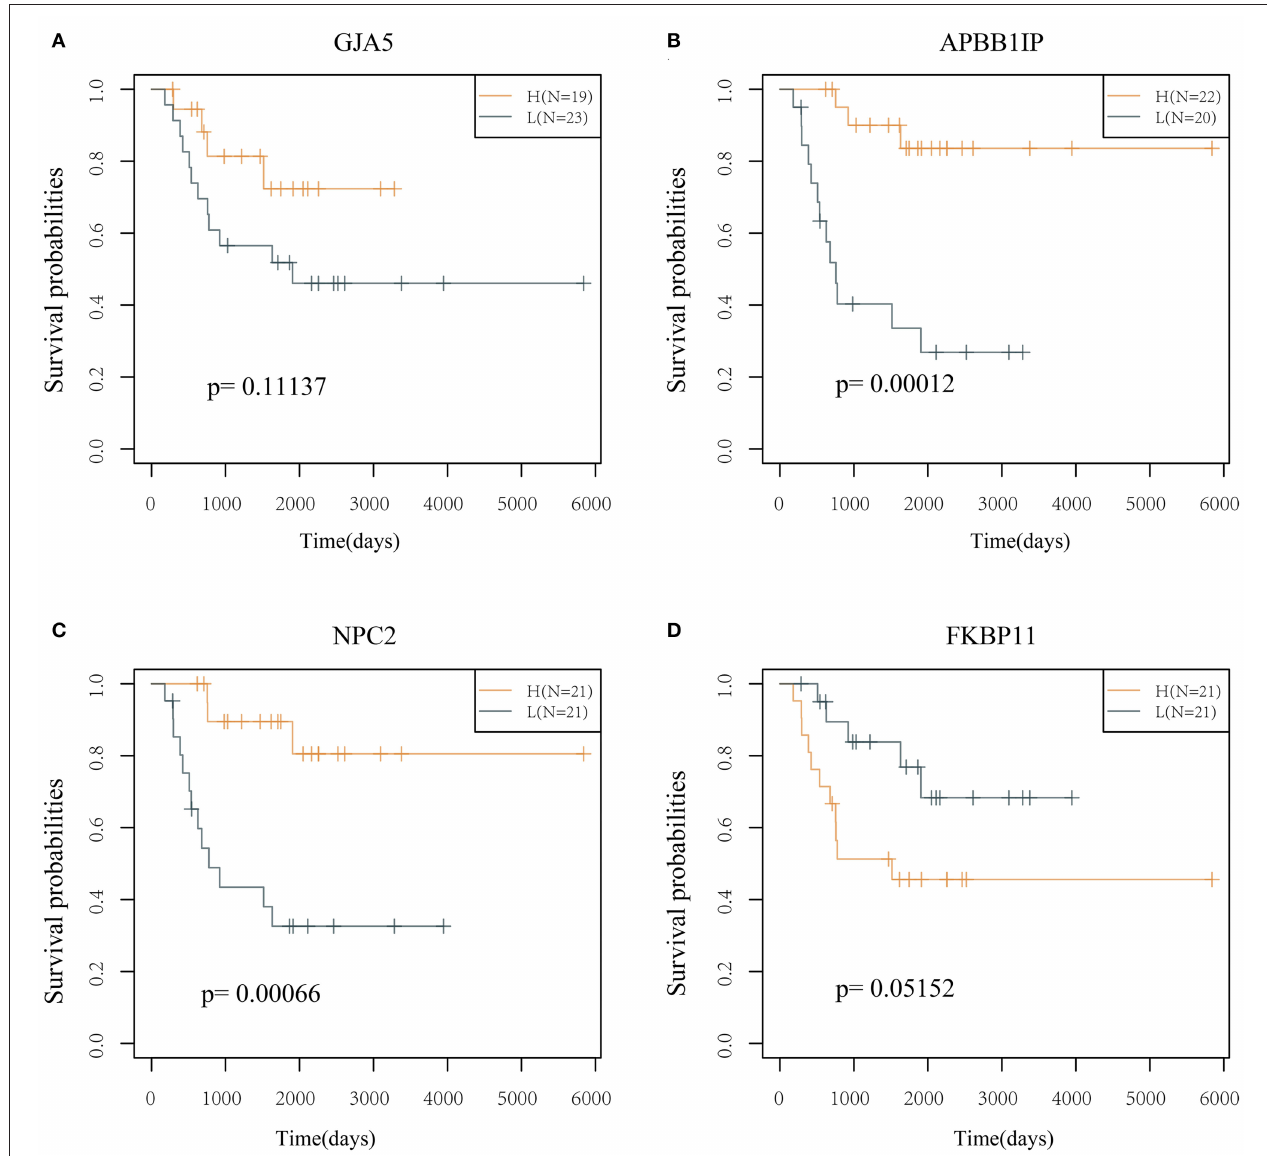
FIGURE 5 | KM curve of the 4 genes (in the TARGET training cohort). (A) The survival curve of GJA5 gene. (B) The survival curve of APBB1IP gene. (C) The survival curve of NPC2 gene. (D) The survival curve of FKBP11 gene. The abscissa represents survival time, and the ordinate represents survival